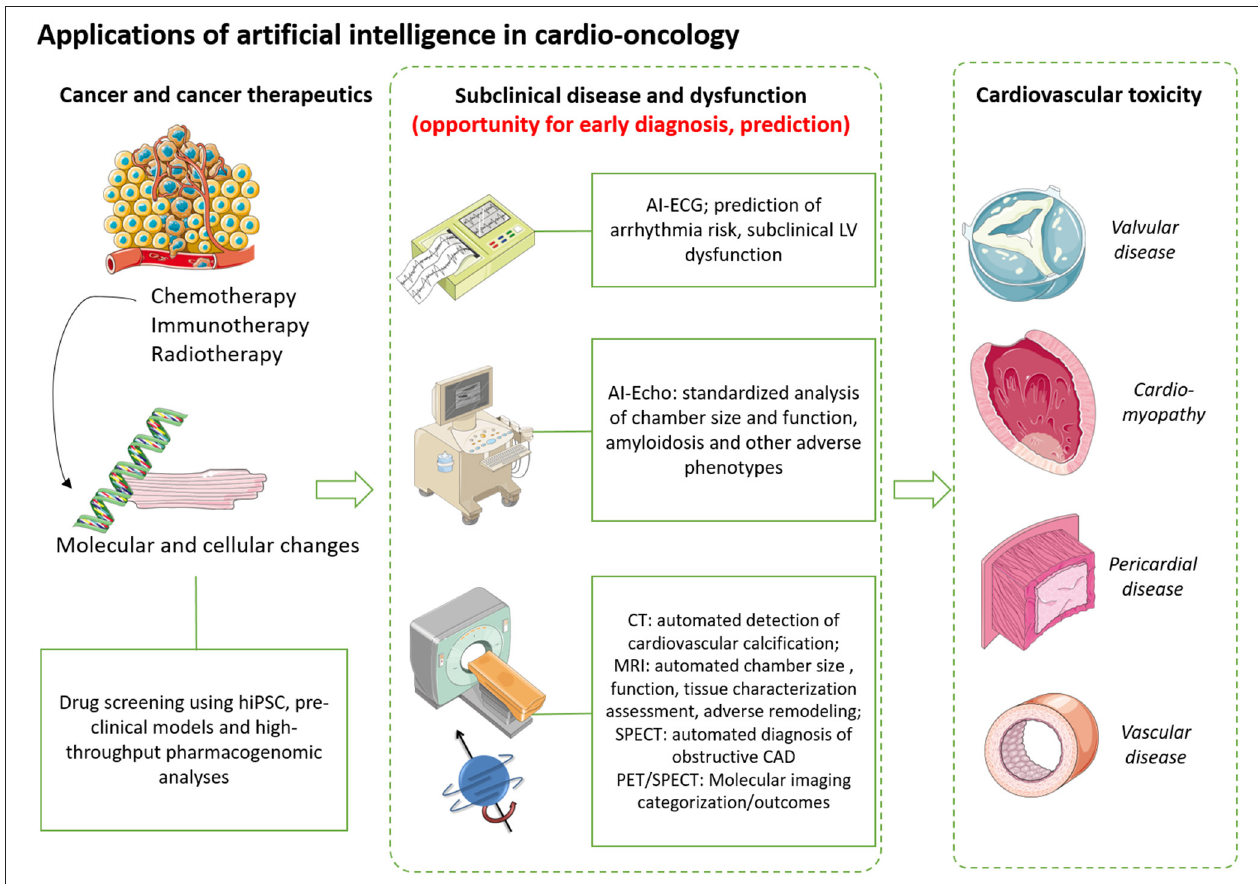
FIGURE 4 | Applications of artificial intelligence, big data in cardio-oncology. Artificial intelligence (AI) can improve our understanding of the early molecular and phenotypic changes that occur prior to the development of clinical cancer therapeutics-related cardiac dysfunction. Machine learning approaches enable high-throughput screening of novel therapeutics using preclinical models, such as induced pluripotent stem cells as well as in silico simulations using libraries of drugs and molecular targets. In the clinical setting, AI can improve risk prediction of left ventricular dysfunction, arrhythmias as well as facilitate accurate and standardized assessment of chamber size, function and coronary calcification, all hallmarks of cardiovascular disease that can be caused or exacerbated by cancer therapeutics. Therefore, AI offers an opportunity for early diagnosis and deployment of strategies to prevent the progression to overt cardiovascular disease. Images have been reproduced under a Creative Commons Attribution 3.0 Unported License from smart.servier.com. CAD, coronary artery disease; CT, computed tomography; ECG, electrocardiography; hiPSC, human induced pluripotent stem cell; LV, left ventricular; MRI, magnetic resonance imaging; SPECT, single photon emission computed